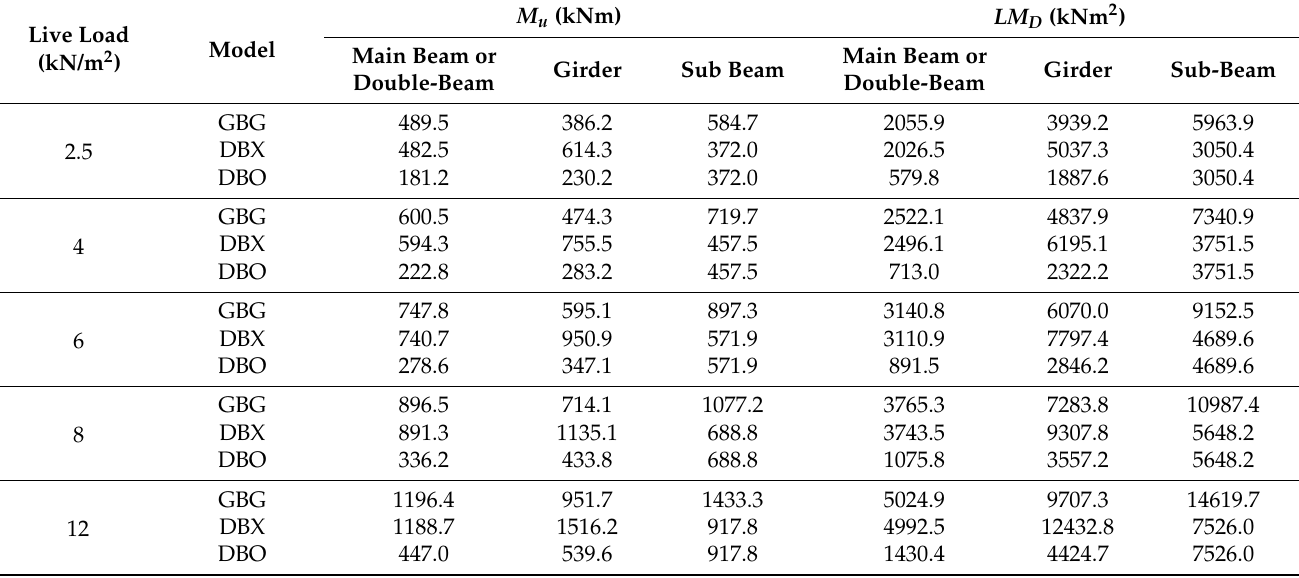
Figure 9. Bending moment diagram in the beam elements according to the structural system. Table 1. Results of moment demands and LM index in terms of demand from frame analysis.